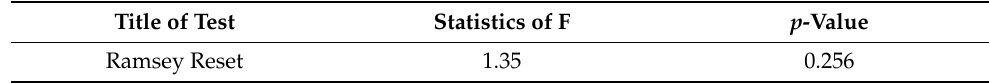
Table 22. Test results specify the second